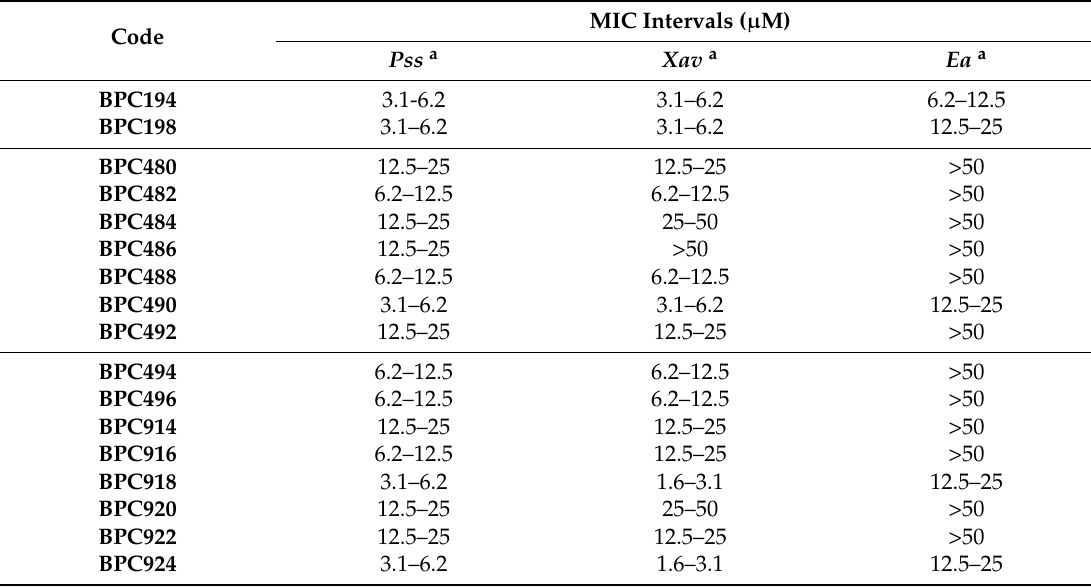
Table 1. Antibacterial activity (MIC) of the cyclic decapeptides.